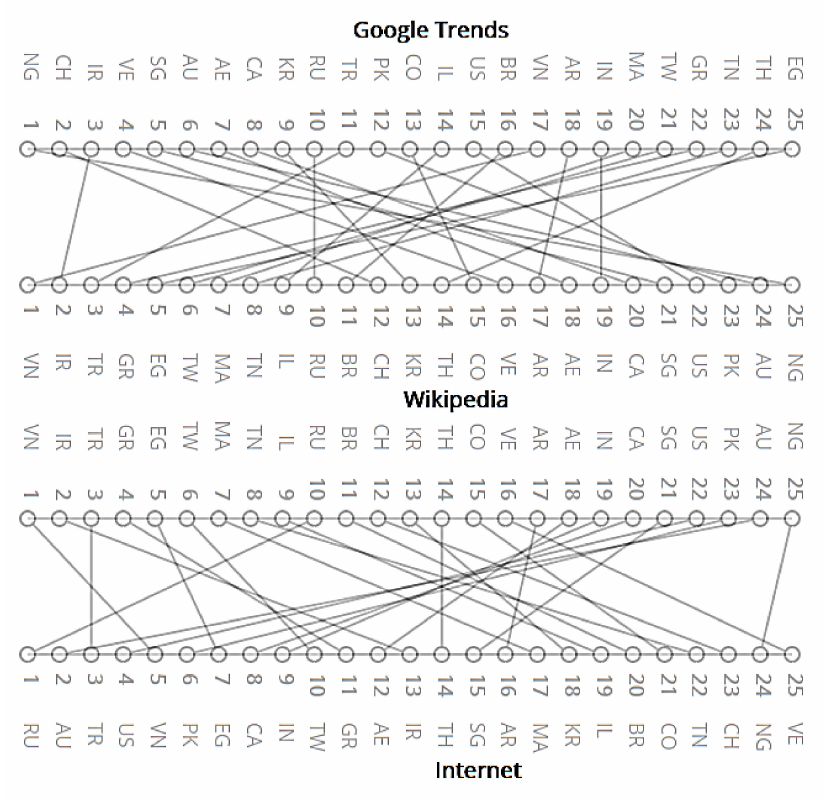
Figure 3. Comparison of Wikipedia, Google Trends and Internet rankings of Bitcoin